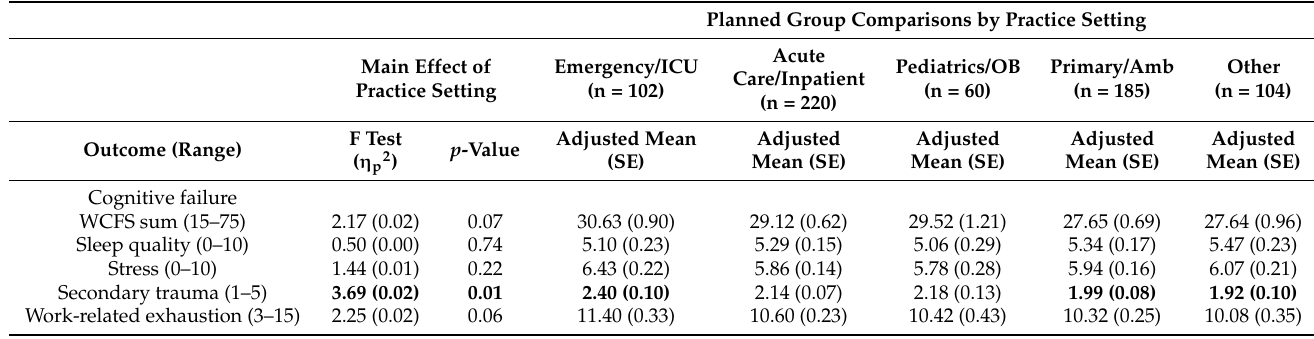
Table 4. Cognitive failure symptoms, well-being, and emotional factors by practice setting (n = 671). Planned Group Comparisons by Practice Setting Main Effect of Emergency/ICU Practice Setting (n =